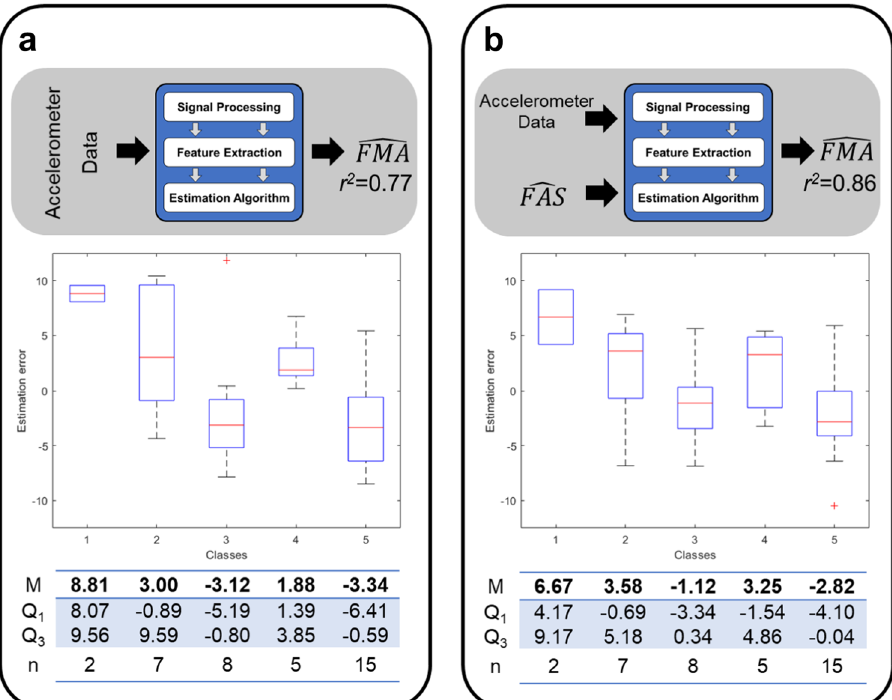
Fig. 2 Estimation error distribution for two of the methods implemented in the study. a Random forest and b proposed technique. M median value, Q1 25th percentile, Q3 75th percentile, n number of subjects per class. See text for